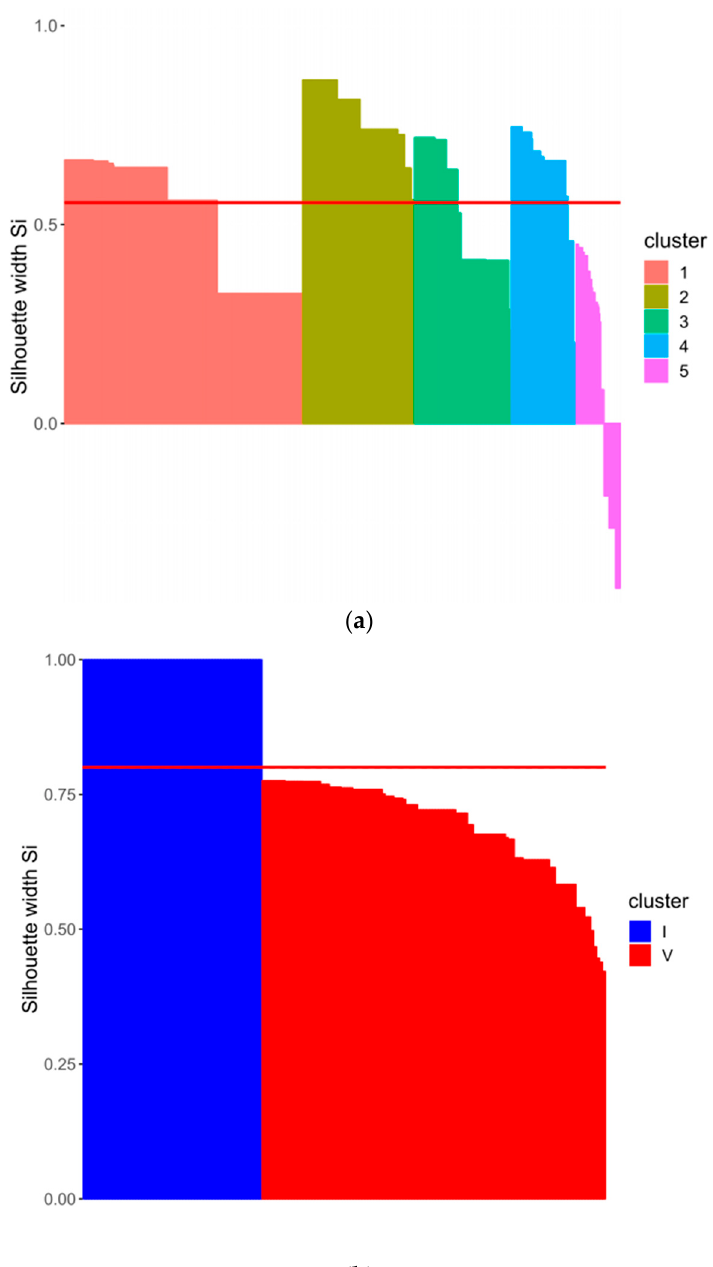
Figure 6. ( a ) Silhouette plot for five k-means cluster groups to show the non-separability. The red line shows the average quality of the clusters. ( b ) Silhouette plot for two k-means cluster groups to show the separability. The red line shows the average quality of the clusters.